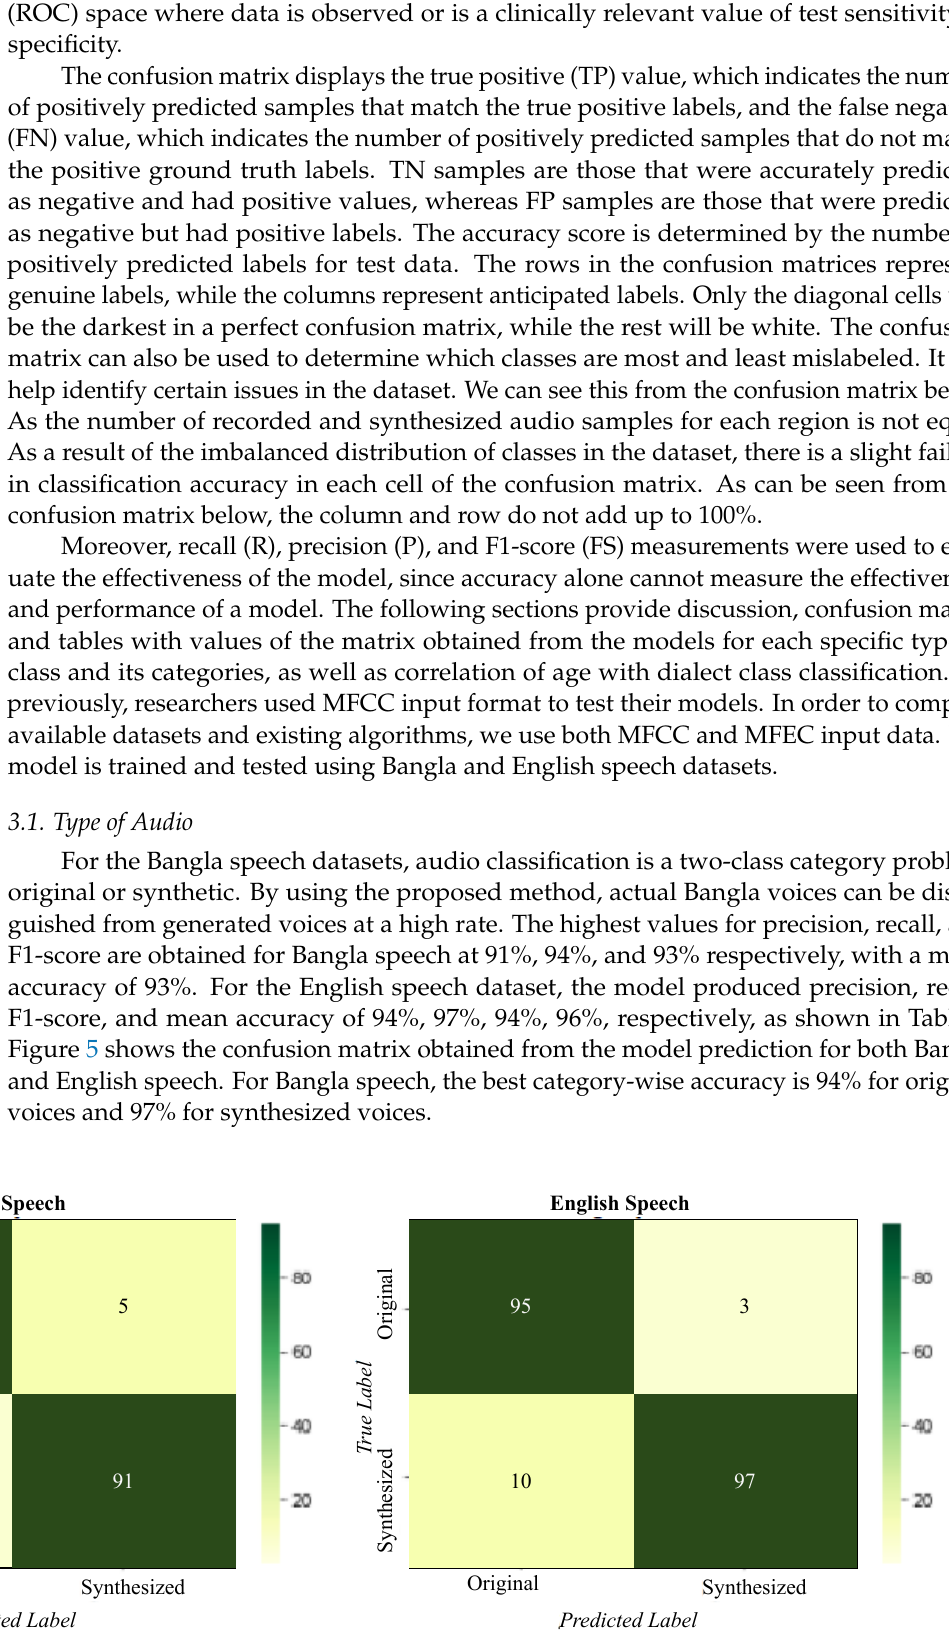
Figure 5. Confusion Matrices of Type of Audio for Bangla and English